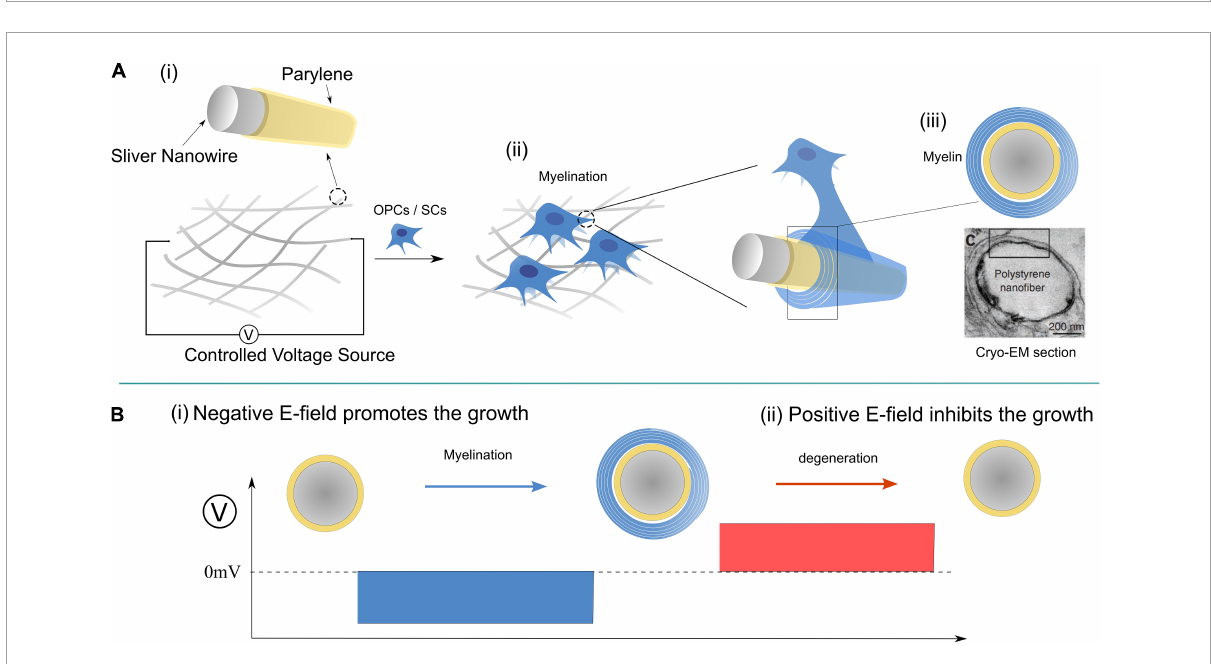
FIGURE10 A designed experiment for validation of Hypothesis-E: (A) The experimental setup; (B) modulate the myelination process by controlling the E-field of the